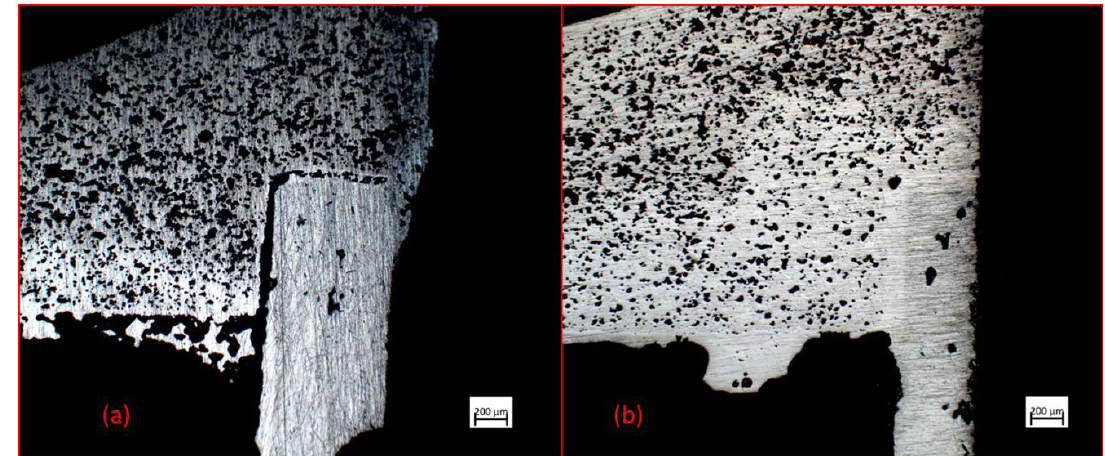
Figure 11. (a) optical micrograph of an 1890°C brazed sample, and (b) optical micrograph of a 1967°C brazed